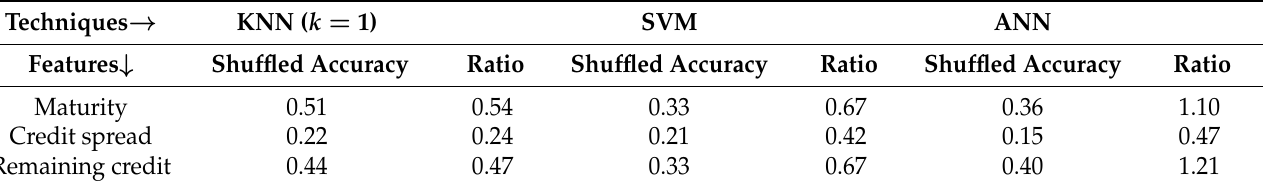
Table 3. Variable importance comparisons with different